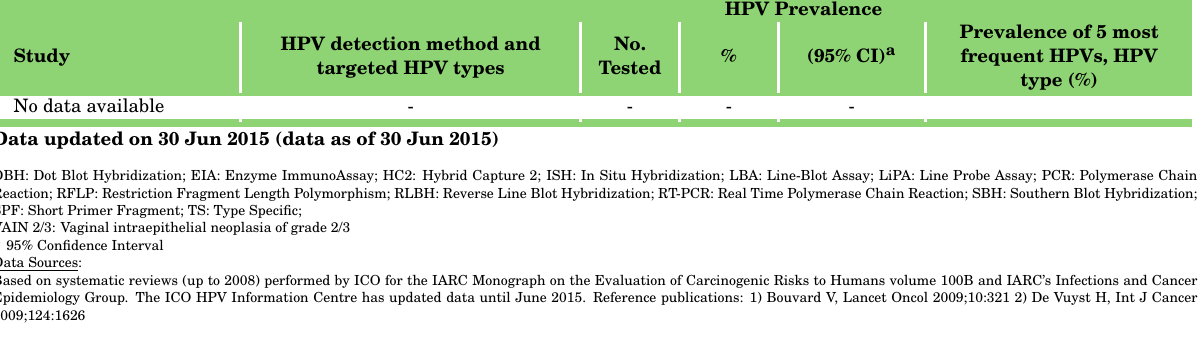
Table 30: Studies on HPV prevalence among VaIN 2/3 cases in Peru